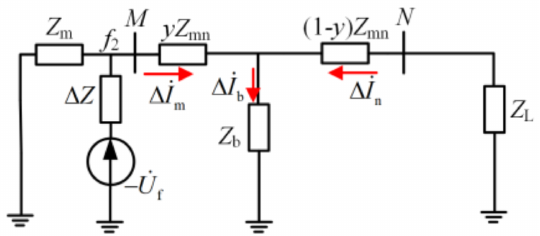
Figure 10. Composite sequence network of the positive-sequence fault component: the UBL is upstream of the fault point in case of an external